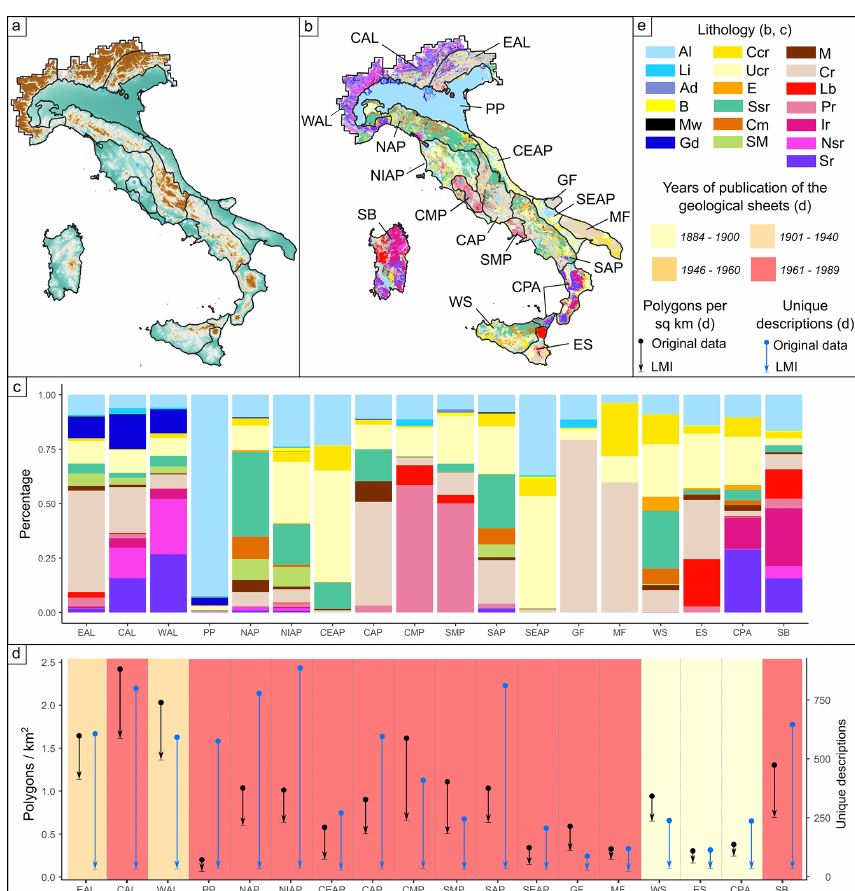
Figure 6. (a) Physical map of Italy subdivided into 18 physiographic regions. (b) Geographical distribution of the 19 identified lithological classes in the 18 physiographic regions of Italy (see Table 4 for spelling out of the acronyms). (c) Percentage distribution of the 19 litholog- ical classes in each physiographic region. (d) Polygon density (black symbols) and number of unique descriptions (blue symbols) in each physiographic region considering the original data (points) and the LMI (arrow tips) and taking into account the years of publication of the geological sheets. (e) Legend. See Fig. 5 for the extended lithological